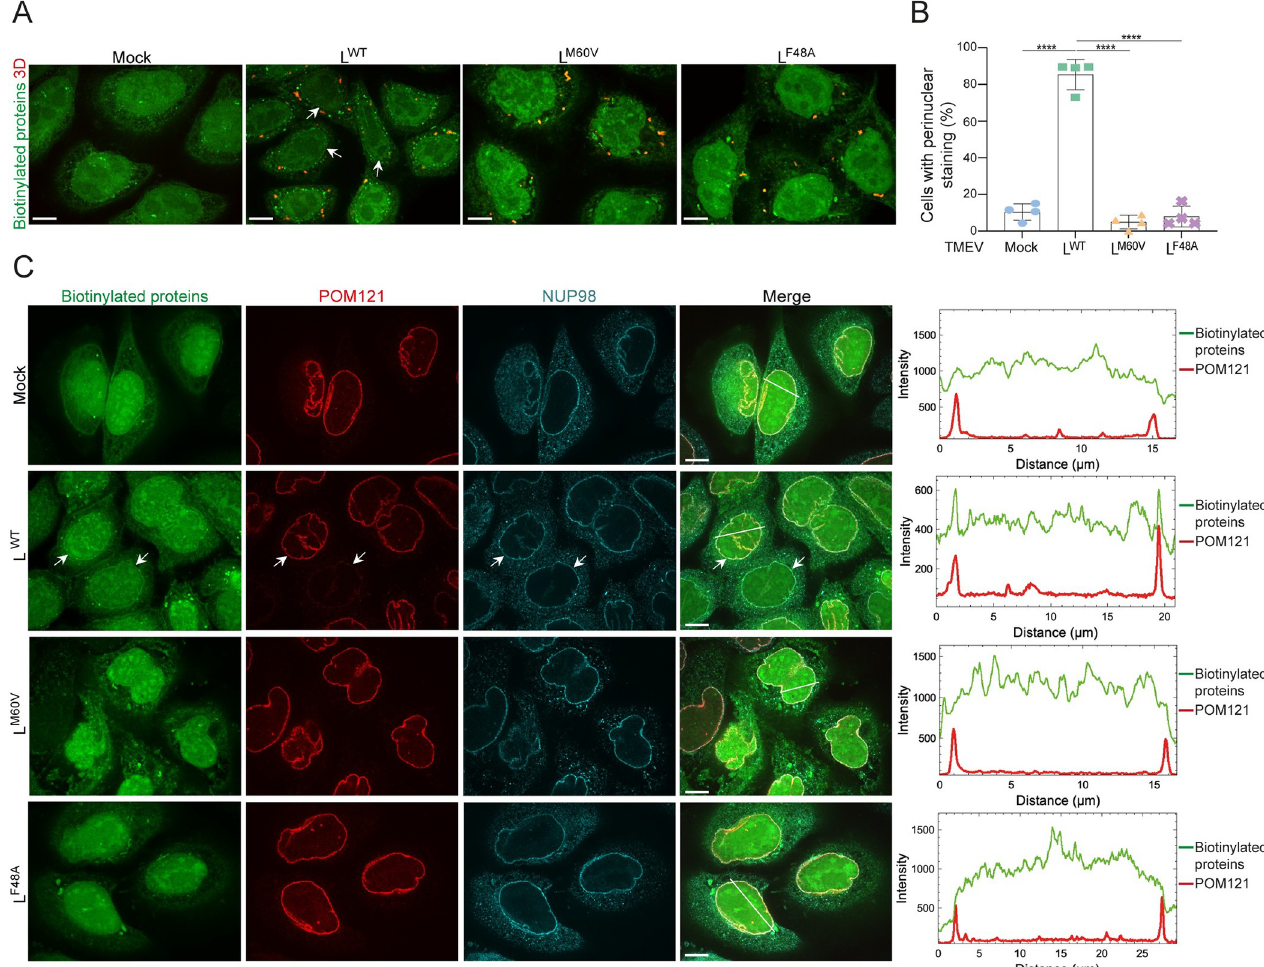
Fig 7. Subcellular localization of proteins biotinylated by BioID-RSK. (A) Confocal microscopy images of biotinylated proteins (green) and 3D viral polymerase (red) detected in BioID-RSK expressing HeLa cells infected with L WT , L M60V or L F48A viruses for 10h (MOI 5). 3D viral polymerase was stained as a control of infection. (B) Quantification of cells showing a visible nuclear rim of biotinylated proteins in HeLa BioID-RSK cells infected with L WT , L M60V or L F48A viruses (mean ± SD). Counts: 50 ± 10 infected cells per experiment (n = 4). One-way ANOVA was used to compare all samples with each other. Shown are significant differences with L WT . (C) BioID-RSK biotinylates proteins that colocalize with the FG-NUPs POM121 and NUP98. Confocal microscopy images and intensity vs distance plots of biotinylated proteins (green), POM121 (red), and NUP98 (cyan) in HeLa BioID-RSK cells infected with L WT , L M60V or L F48A viruses in parallel to cells shown in panel A. White arrows point to examples of cells exhibiting a nuclear rim staining. Scale bar: 10 μ m.